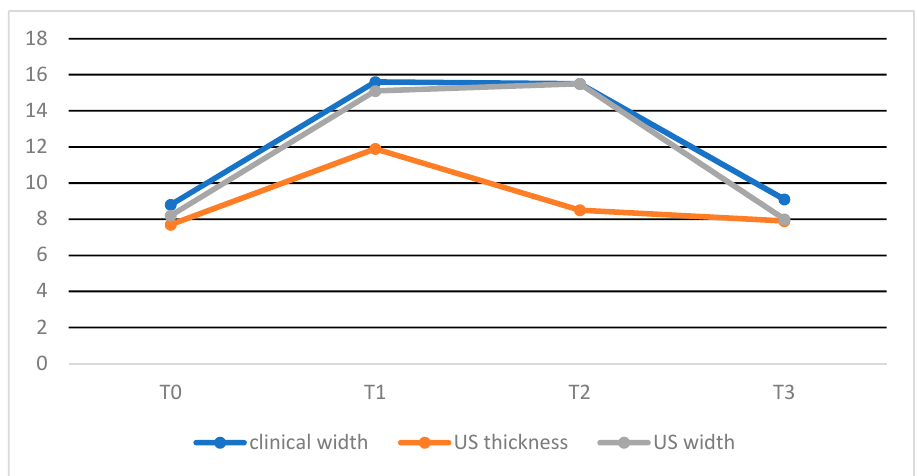
Figure 6. Graphic representation of progression of tendon dimension at each time point, expressed in mm.